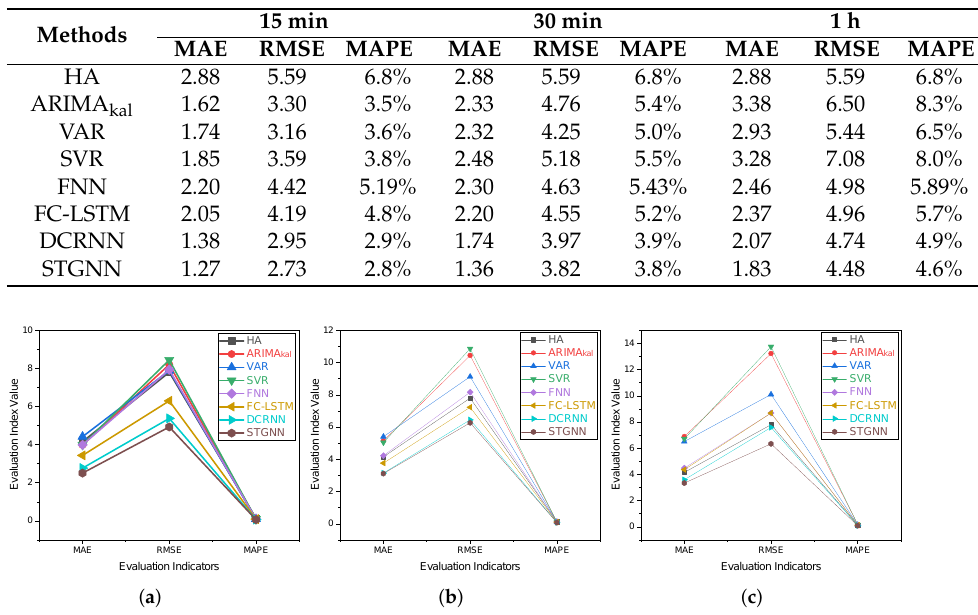
Table 2. Performance comparison of traffic speed prediction of multiple models on d PEMS-BAY dataset.